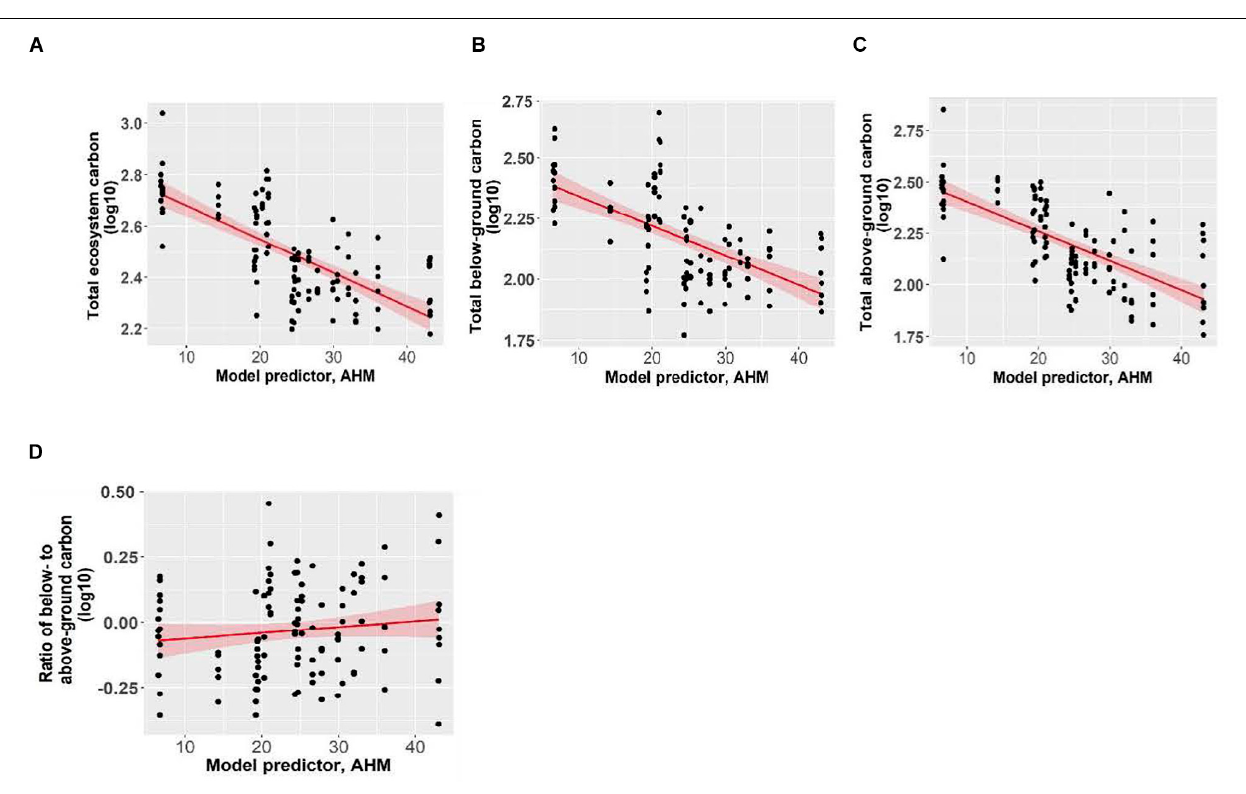
FIGURE 5 | The effect of annual heat moisture index (AHM; 1981-2010) on panels (A) total ecosystem carbon, (B) total belowground carbon, (C) total aboveground carbon, and (D) ratio of below- to above-ground carbon of Douglas-fir dominated forests. Pseudo coefficients of determination were obtained for linear mixed effects models. Marginal R 2 = 0.34 for total ecosystem carbon, R 2 = 0.40 for total above-ground carbon, R 2 = 0.23 for total below-ground carbon and R 2 = 0.01 for the ratio (non-significant). Each point represents one measurement per plot (113 plots in total). The figures present log 10 -transformed